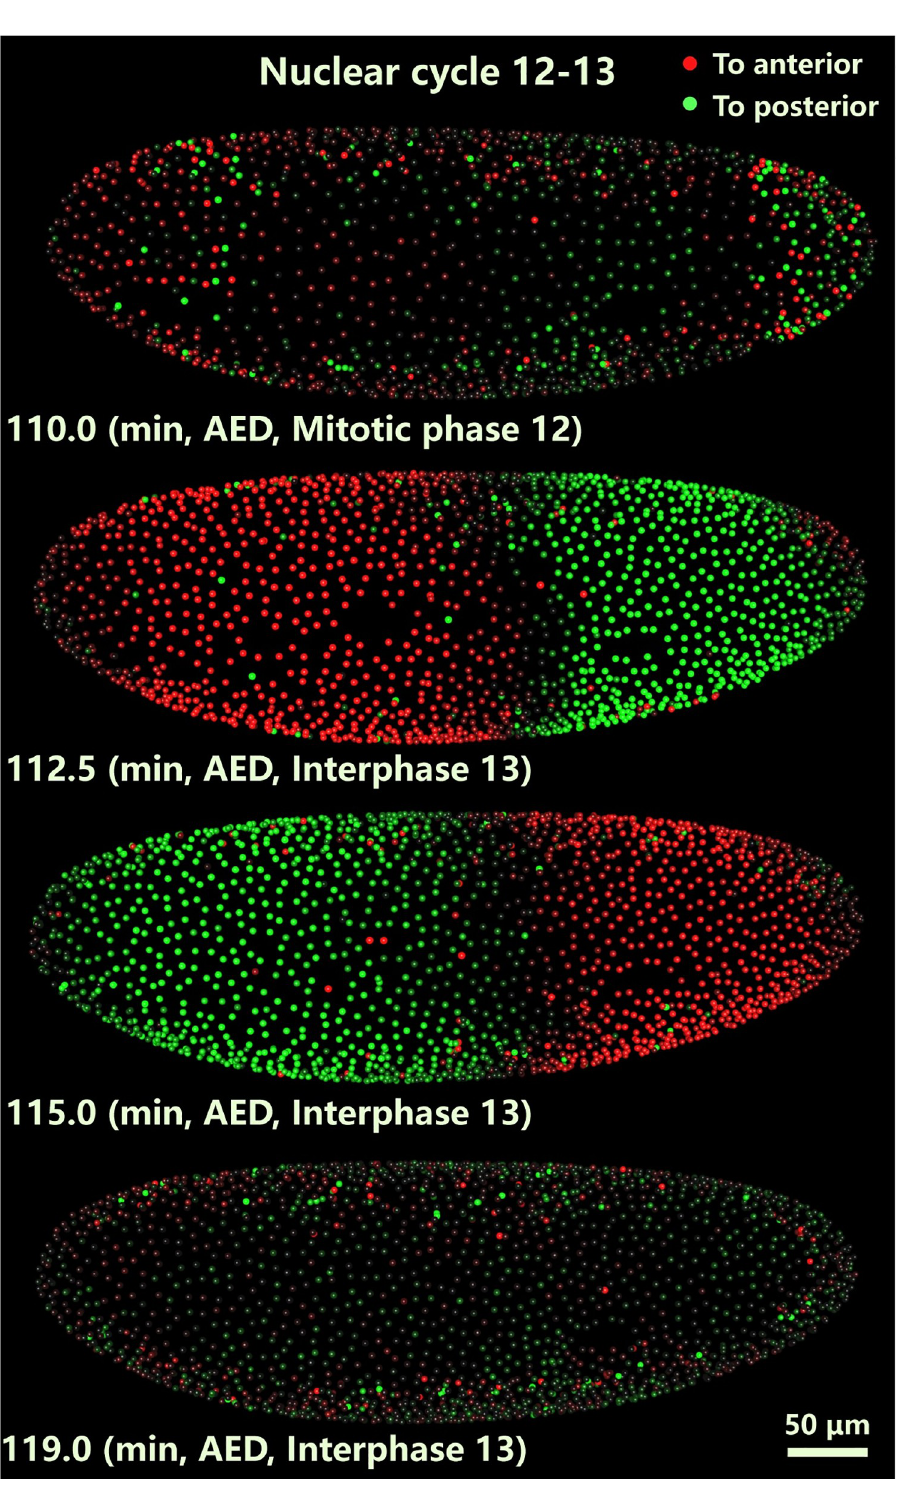
Fig 1. Representative images of the collective motion of the nuclear array of a Drosophila embryo (snapshots from S1 Movie). These images are the projections from the 3D images taken with light sheet microscopy. Each nucleus is segmented and marked with a different color to show the direction of the nuclear velocity along the AP axis (red and green represent the left (anterior) and right (posterior) direction, respectively. And the intensity indicates the magnitude of the nuclear